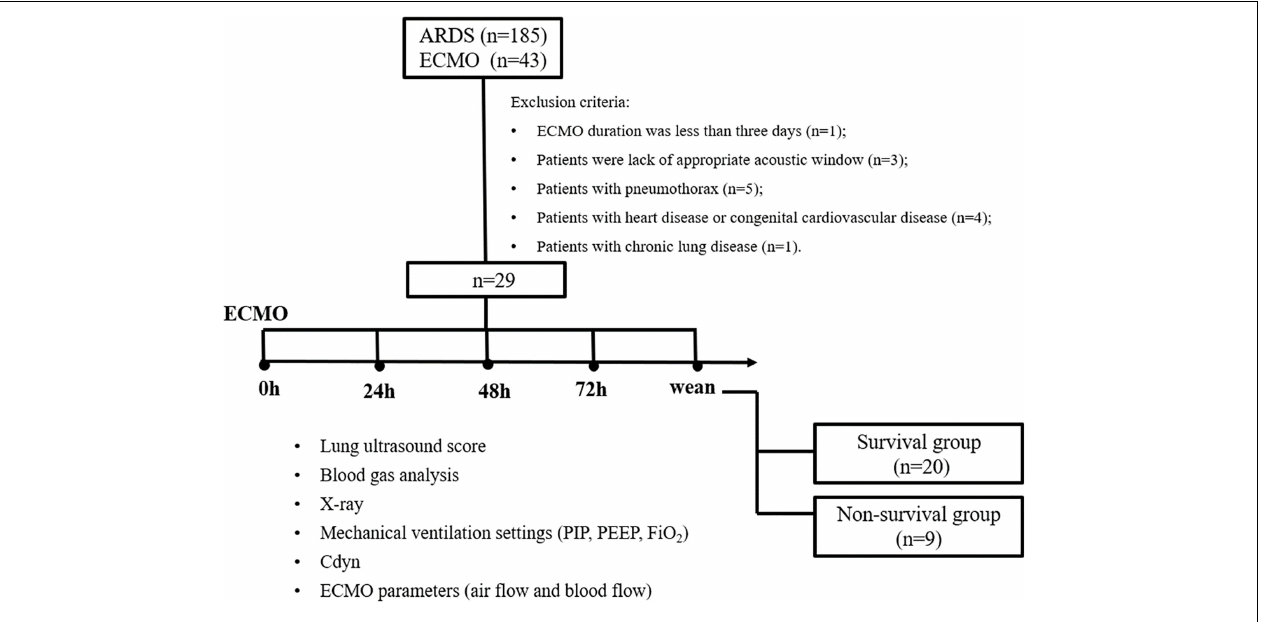
FIGURE 1 | Flowchart of patients’